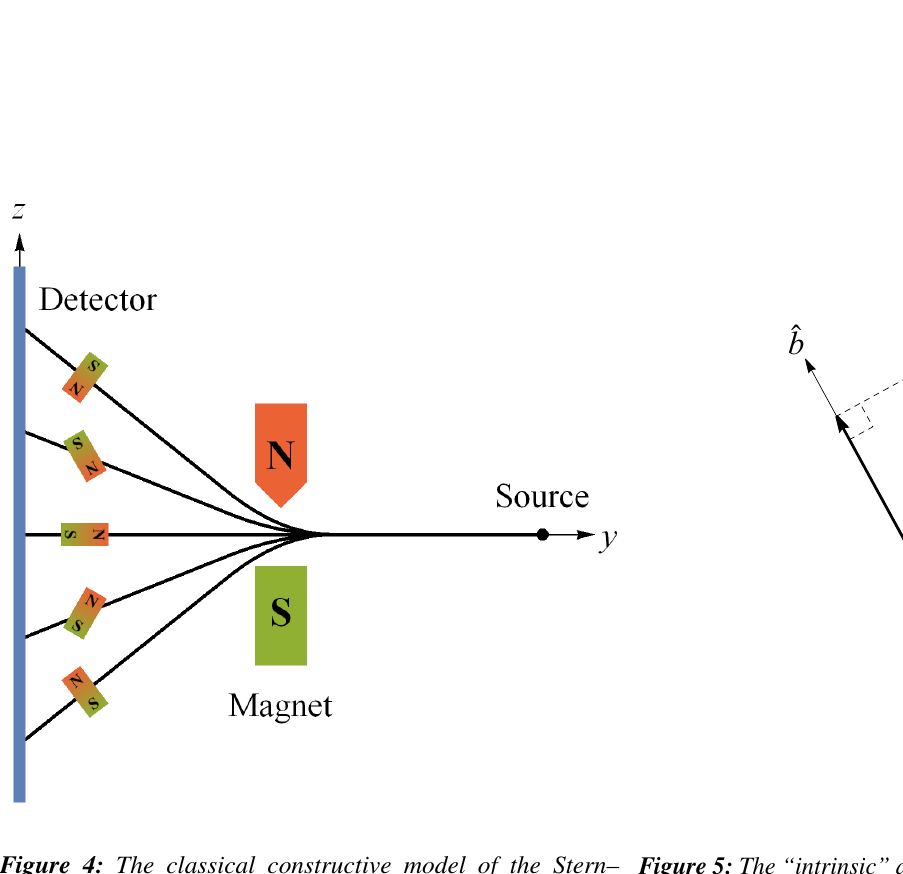
Figure 5: The “intrinsic” angular momentum of Bob’s particle ⃗ S projected along his measurement direction ˆ b. This does not happen with spin angular momentum due to NPRF. Reproduced from Stuckey et al.